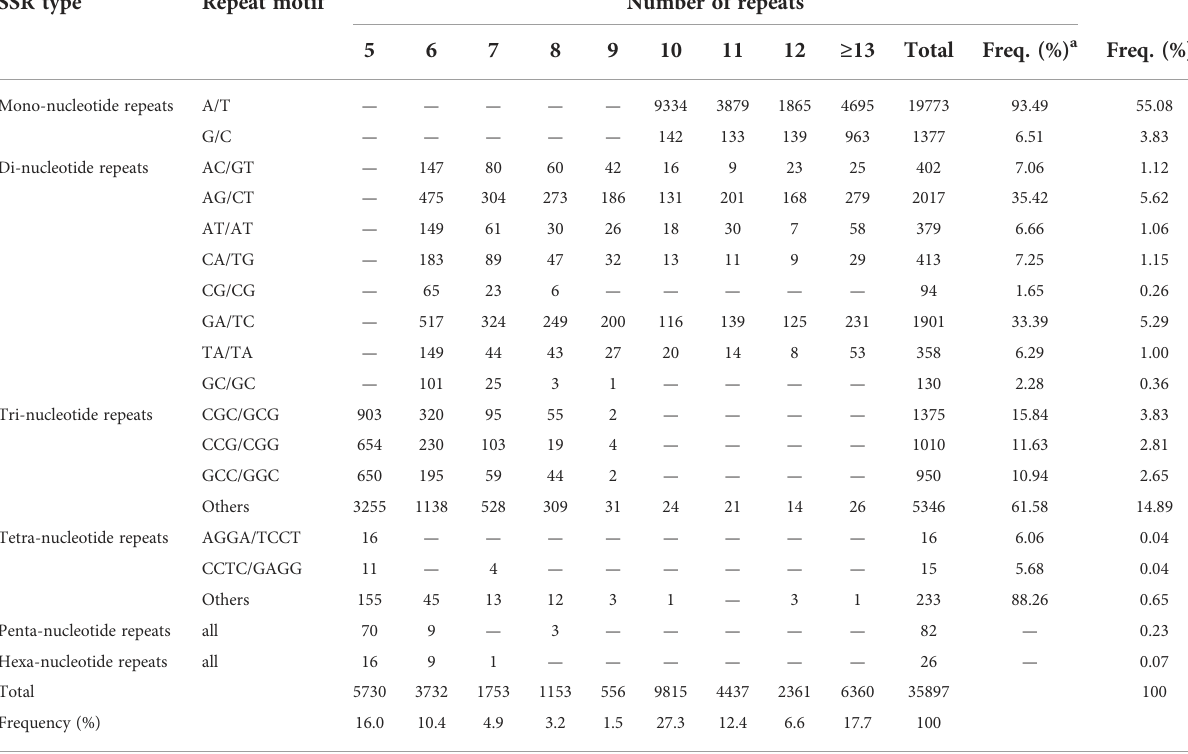
TABLE 4 Summary of perfect SSRs identi fi ed within the unigenes assembled in this studies: The number of mono, di, tri, tetra, penta, and hexa- nucleotide repeat SSRs for different number of repeats and their corresponding percentage within each SSR type and overall. SSR type Repeat motif